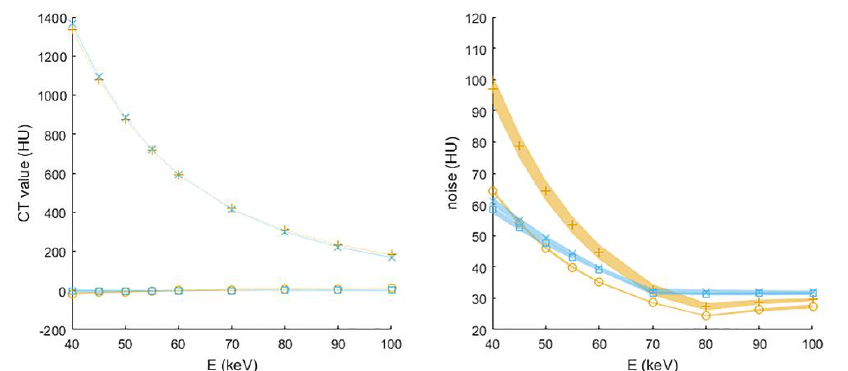
Figure 4. Mean ( left ) and standard deviation ( right ) of CT values (numbers expressed in Hounsfield units (HU)) in water and water with iodine as a function of virtual monoenergetic energy E (keV) for the medium sized abdomen phantom reconstructed without iterative reconstruction technique. For EID-based dual-energy data, circles and plus signs correspond to ROI’s in water and water with iodine, respectively. For single-energy 120 kVp PCD-CT, squares and crosses correspond to ROI’s in water and water with iodine, respectively. Symbols depict the estimated value based on three scans and the accompanying shaded boundaries depict the standard error of this estimate.